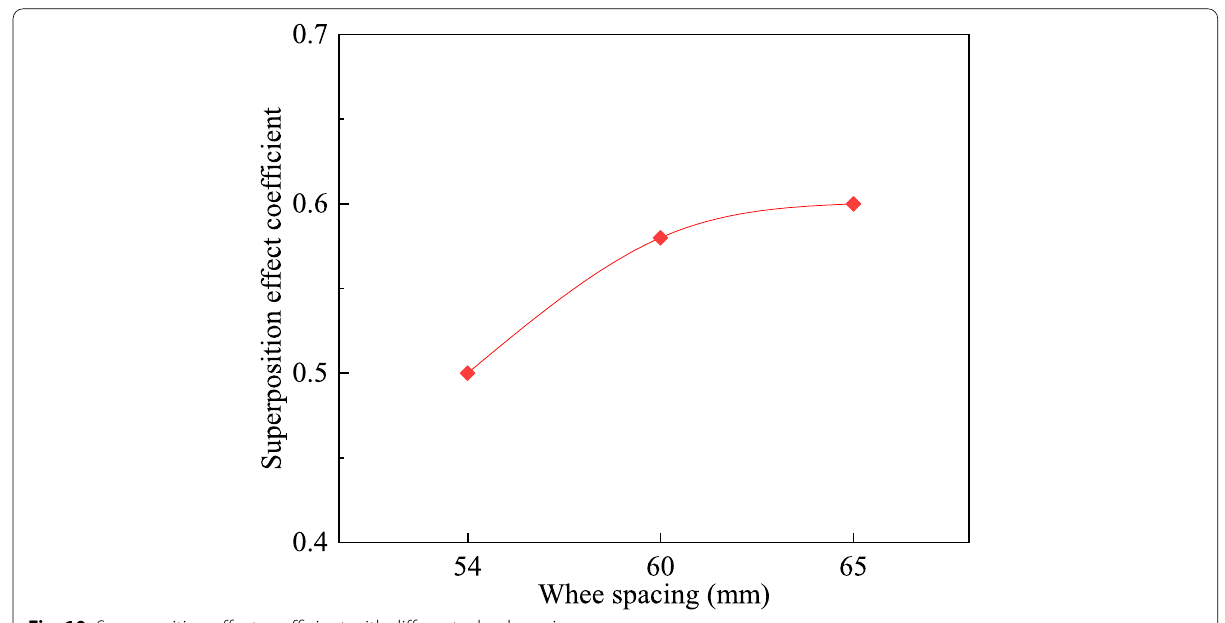
Fig. 10 Superposition effect coefficient with different wheel